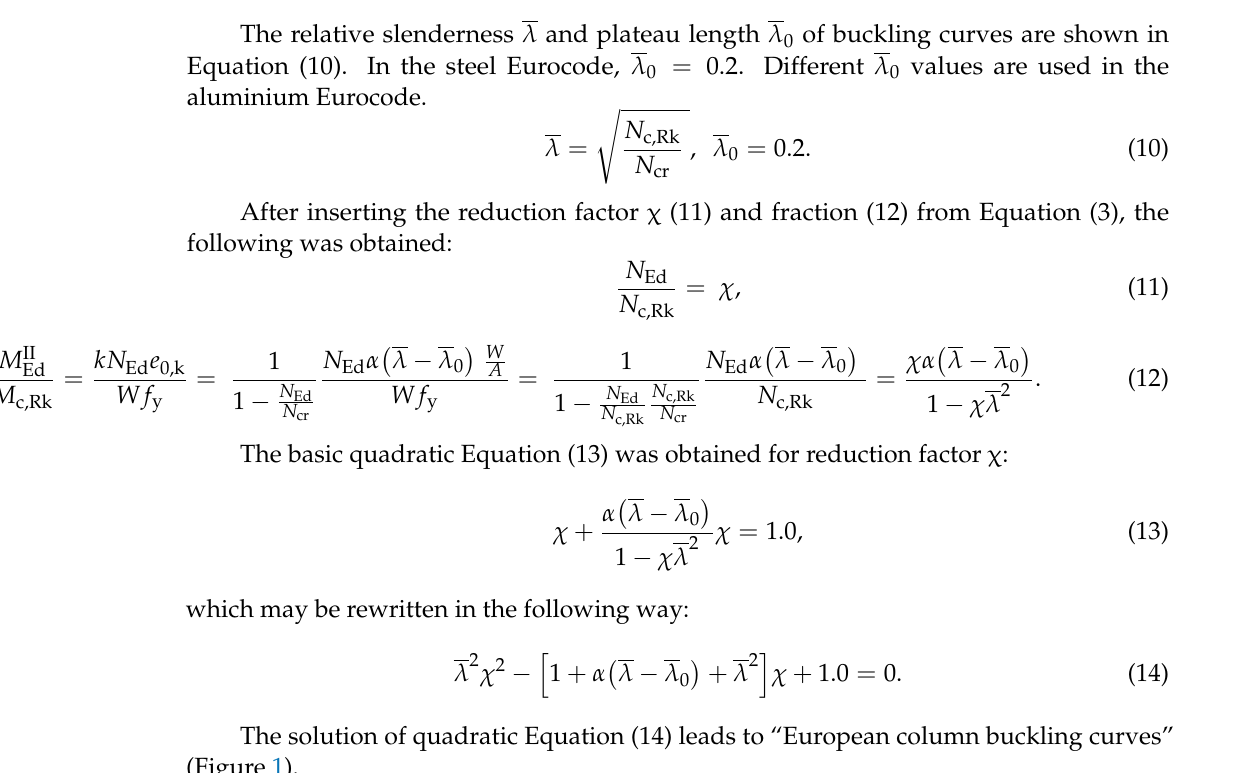
Table 1. Values of imperfection factors α for ideal member and buckling curves. For Buckling Curves (b.c.s) For Ideal Imperfection Member a 0 a b c d Factor α 0 0.13 0.21 0.34 0.49